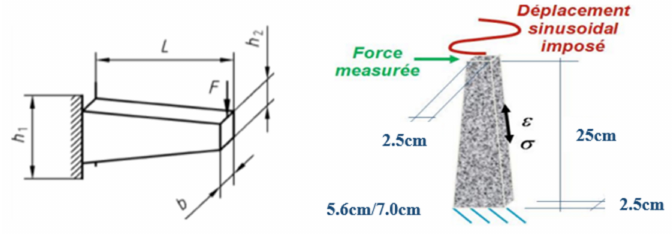
Figure 3. Dimensions of trapezoidal beam